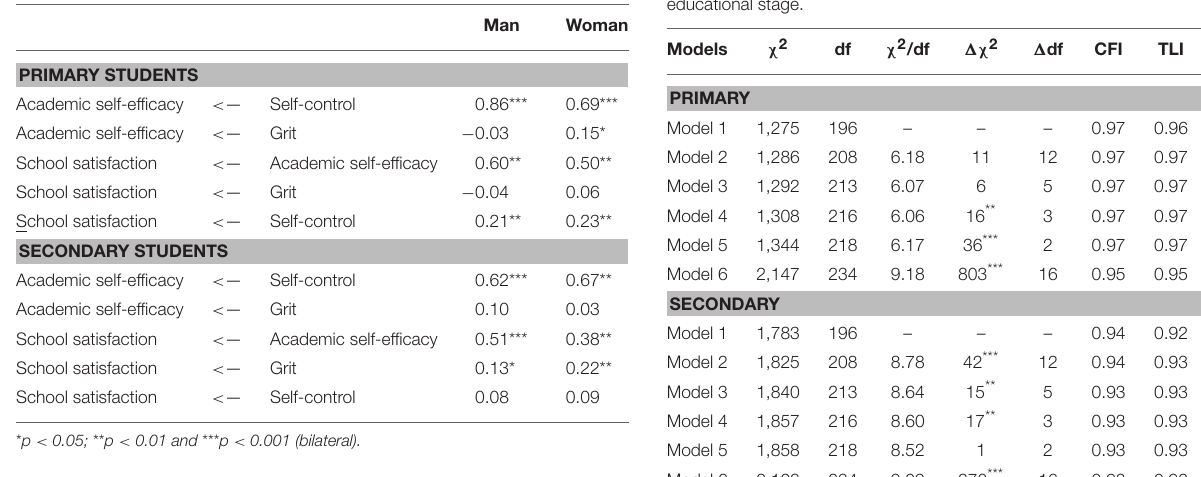
TABLE 6 | Direct effects according sex for primary and secondary students. TABLE 7 | Invariance of models between men and women according to